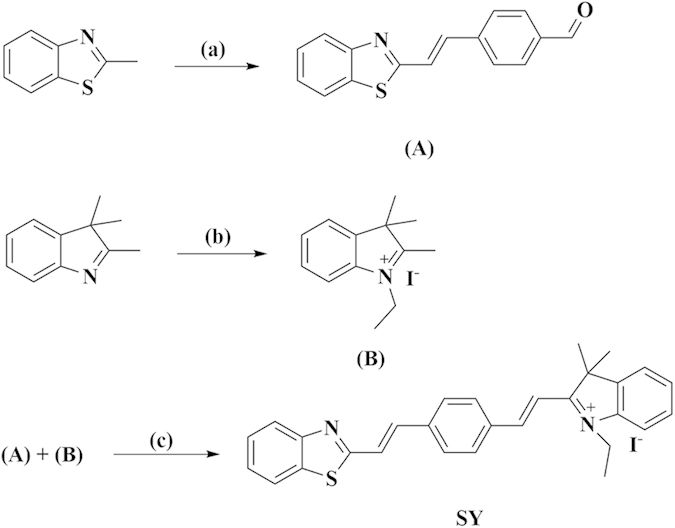
The synthesis of SY.Reagents and conditions: (a) 1,4-phthalaldehyde, acetic anhydride, acetic acid, 120°C, 6 h; (b) ethyl iodide, CH3CN, reflux, 24 h; (c) acetic anhydride, CH2Cl2, anhydrous sodium acetate, stirring, 10 h.